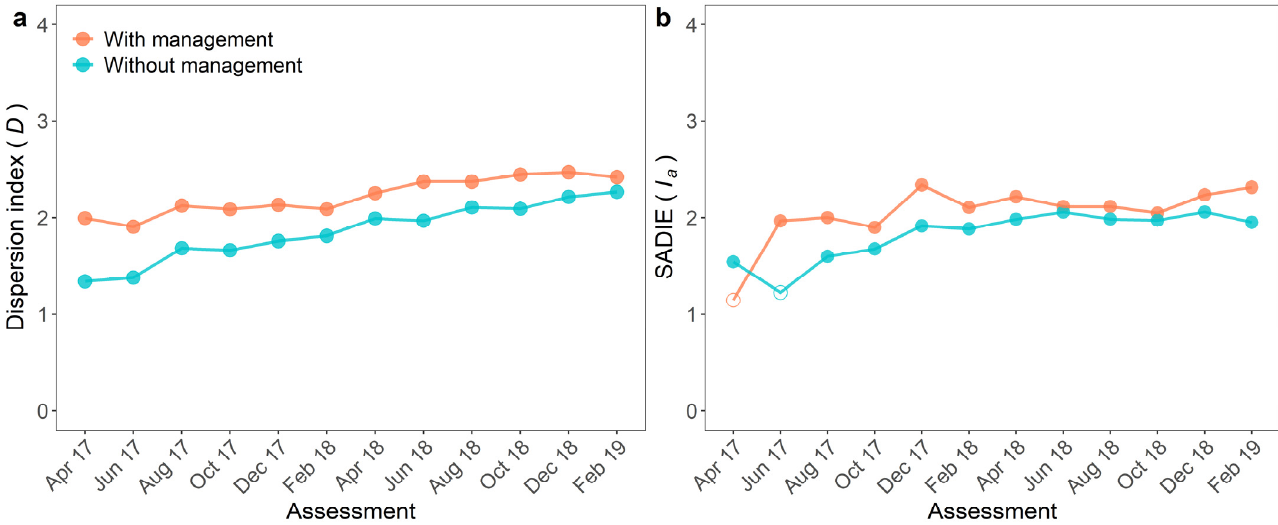
Figure 3. ( a ) Dispersion index ( D ) and ( b ) aggregation index ( I a ) of Spatial Analysis by Distance Indices ( SADIE ) of incidence of Fusarium wilt of banana in two plots, with and without management of weevil borer ( Cosmopolites sordidus , WB), from April 2017 to February 2019. Significant ( p < 0.05) and non-significant ( p > 0.05) values are represented by filled or empty circles, respectively, in the plot under a given management system, at a given date. When p < 0.05, the spatial pattern was considered aggregated.